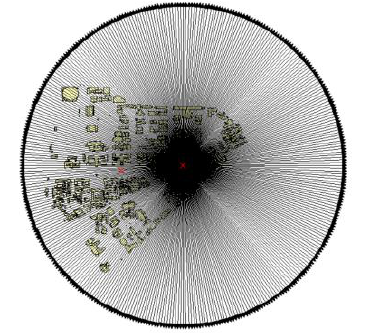
Figure 15. Calculation of elevation angle from each direction